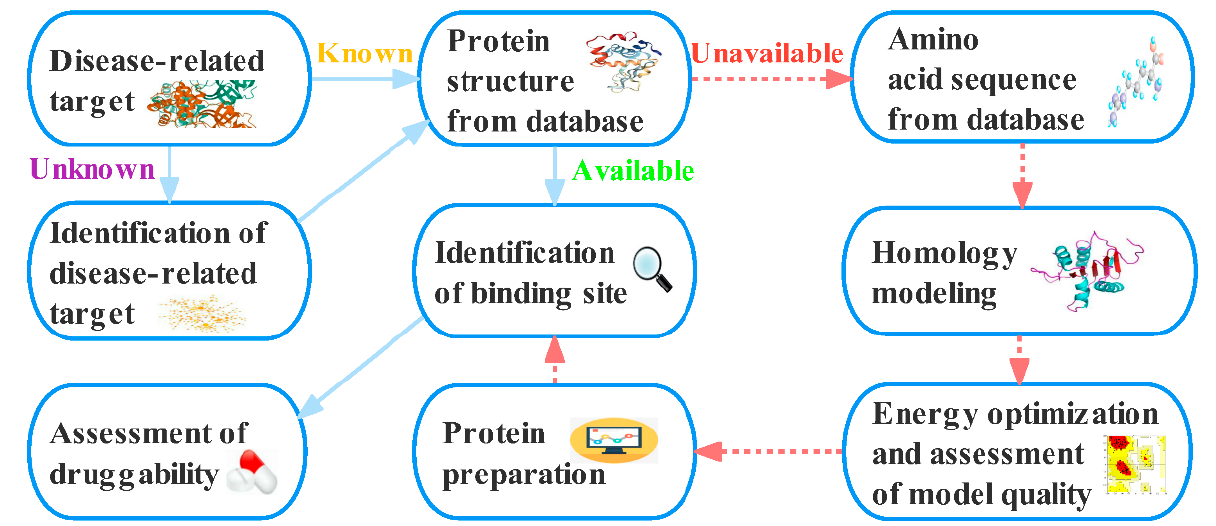
Figure 1. Flow chart of computer-based identification of potential drug targets. Computer-based target identification mainly involves disease-related target